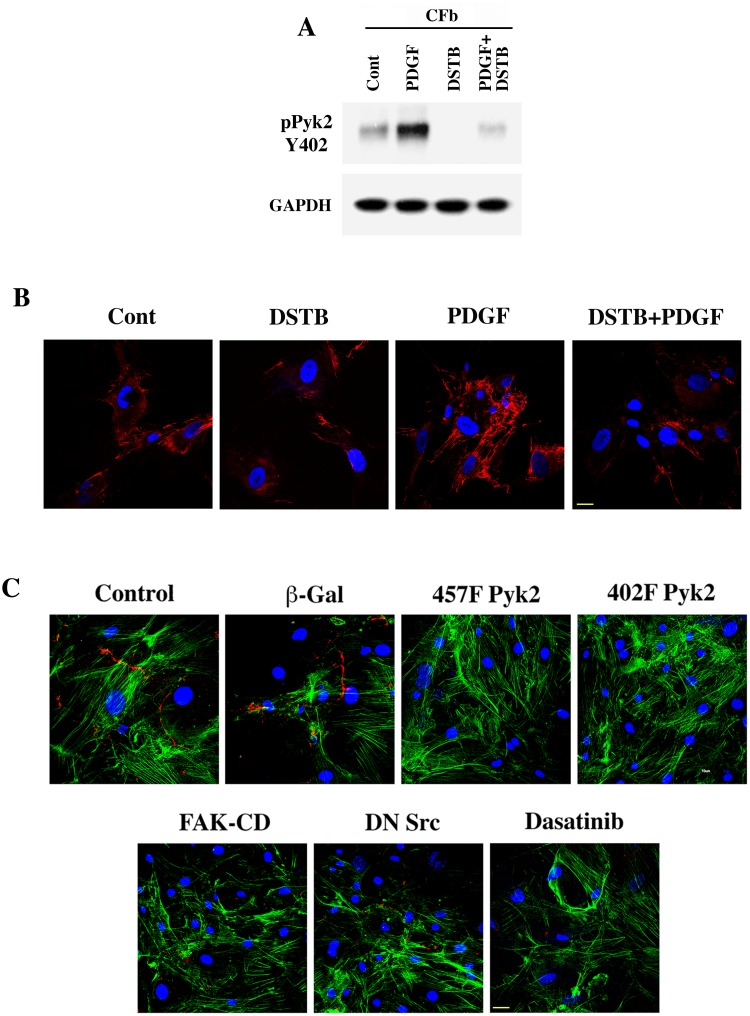
Reduction of PDGF-stimulated fibronectin accumulation and Pyk2 activation in dasatinib treated CFb.
(A) CFb grown on 35 mm culture plates were pretreated with ± 50 nM dasatinib for 30 min and then stimulated with 10 ng/ml PDGF for 30 min. Triton X-100 soluble proteins were used for Western blot analysis using phospho-tyrosine Pyk2 402 antibody. Western blotting with GAPDH antibody was used to monitor protein loading. (B) CFb grown on coverslips were pretreated with ± 50 nM dasatinib for 30 min and then stimulated with 10 ng/ml PDGF for 24 h. After 24 h treatment, cells were fixed and immunostained with anti-fibronectin antibody (red) and nuclear stained with DAPI (blue). Results were confirmed in two additional experiments (n = 3). Scale bar, 10 μm. (C) CFb grown on coverslips for 12 h in 10% FBS containing media were infected with adenoviruses for the expression of β-gal (control), Y457F mutant Pyk2, Y402F Pyk2, Fak c-terminal domain, and dominant negative c-Src for 36 h or treated with dasatinib (50 nM) for 24 h. Cells were then used for immunostaining for fibronectin (red) and actin (green) with specific antibodies and for the nucleus (blue) with DAPI. Results were confirmed in one additional experiment. Scale bar, 10 μm.